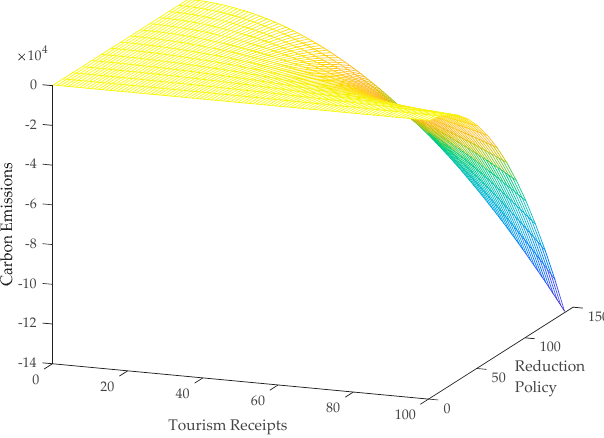
Figure 3. Effect of tourism on carbon emissions using reduction policy as the moderator.